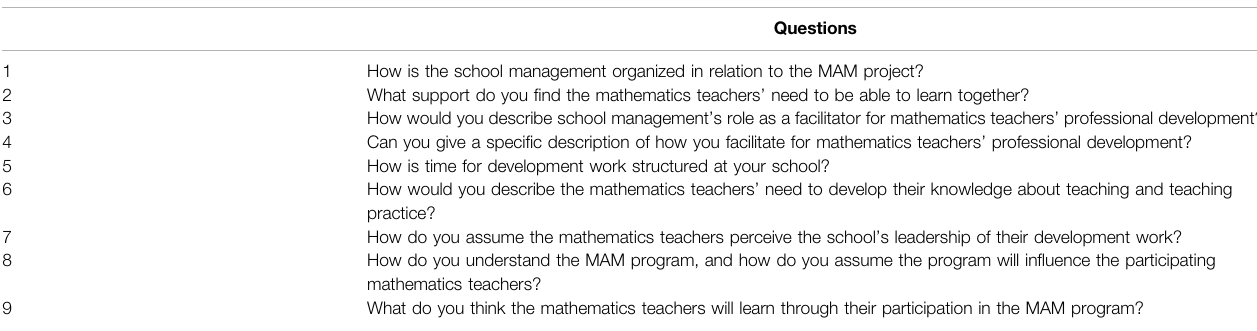
TABLE 1 | Structure of the focus-group interview guide for the school management, fall